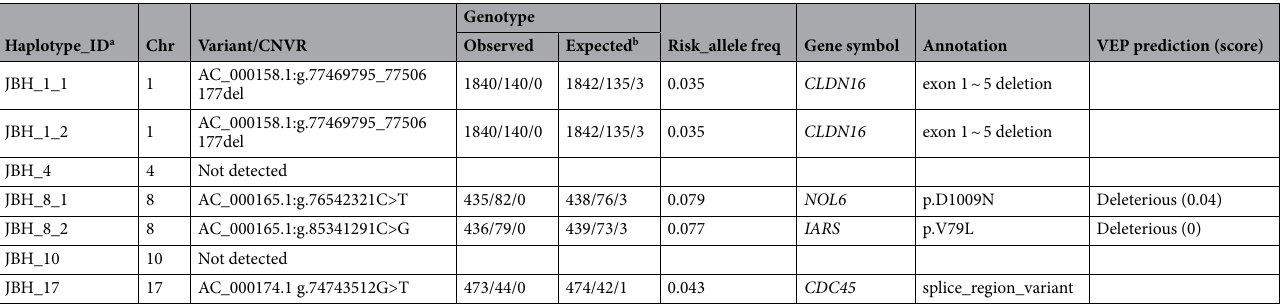
Table 4. Candidate variants and CNVRs with homozygous haplotype deficiency in 517 Japanese Black sires and 1463 Japanese Black cattle. a Haplotype IDs consist of “JBH” for “Japanese Black haplotype,” followed by chromosome number. b The expected number of genotypes was calculated using the frequencies of alleles when assuming random